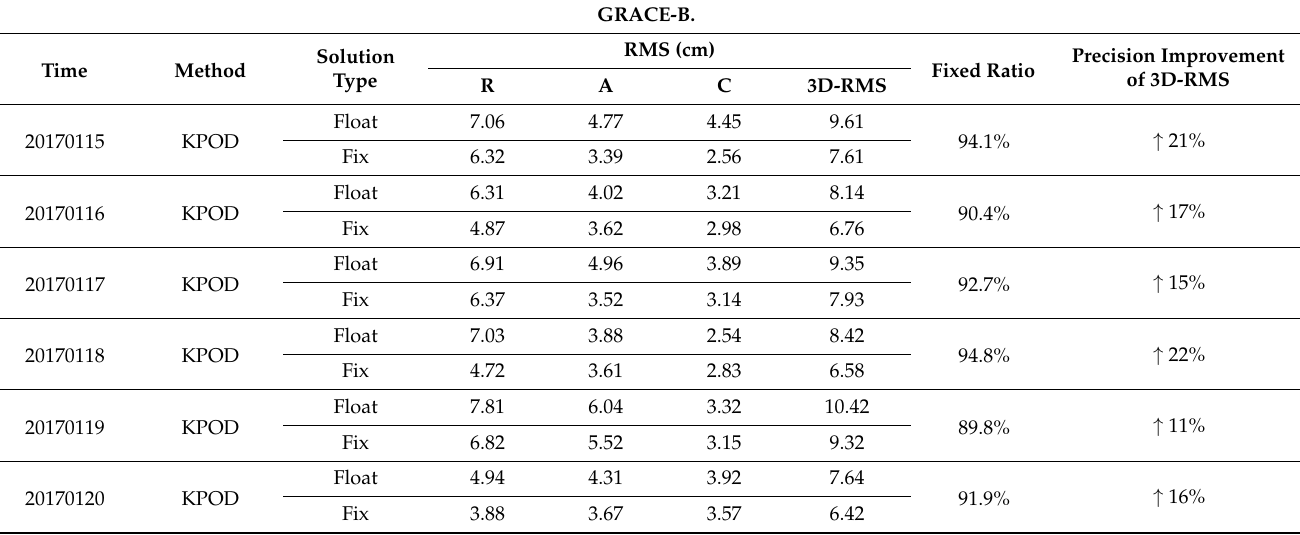
Table 3. The GRACE-B ambiguity-fixed ratio and RMS of real-time KPOD in R (radial), A (along- track), and C (cross-track) directions and 3D-RMS (total position error) with different solution types.